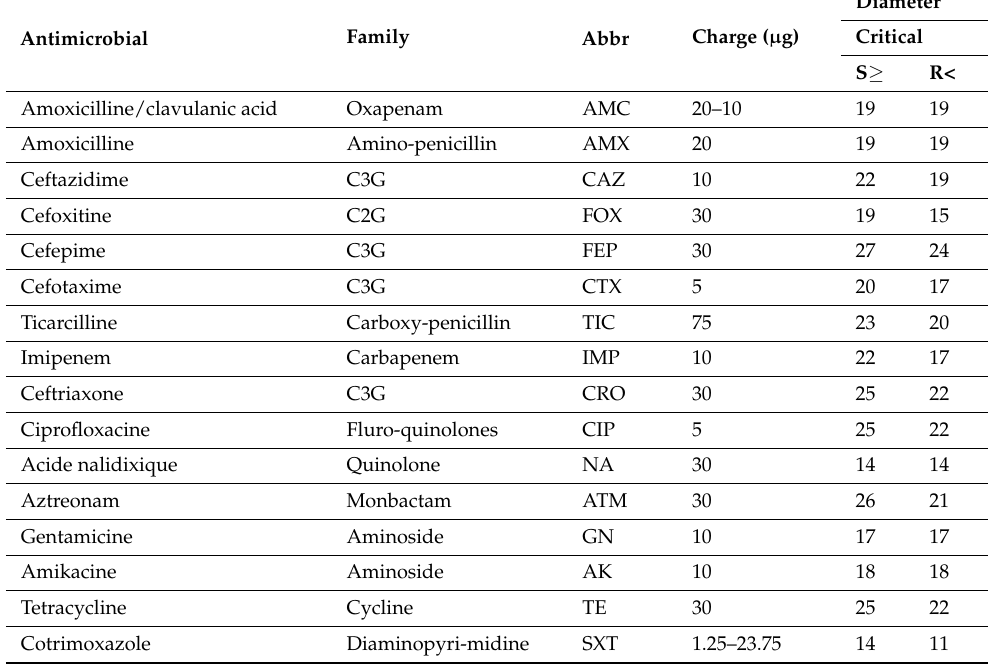
Table 6. Table of antimicrobials used (EUCAST 2020).